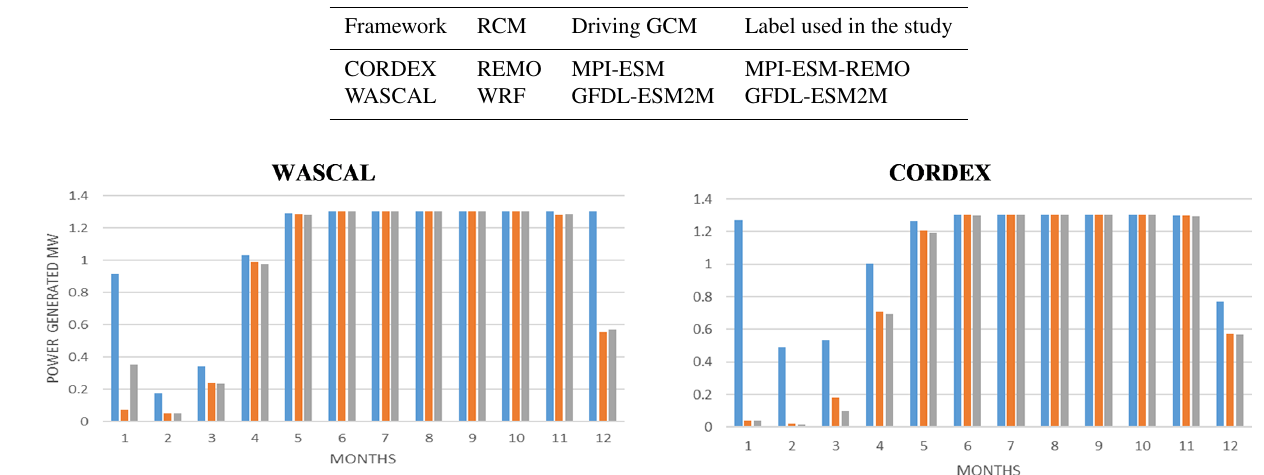
Table 2. RCM–GCM products and the corresponding label used in the study.